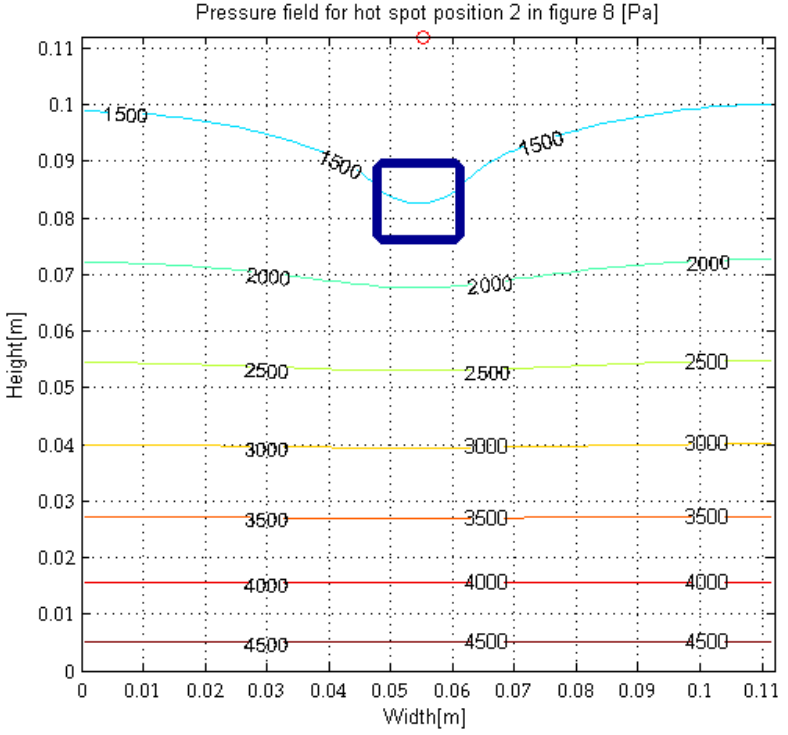
Figure 9. The pressure field for a 0.112 wide and 0.112 m high wick with a hot spot ( q hot spot / q normal = 15).